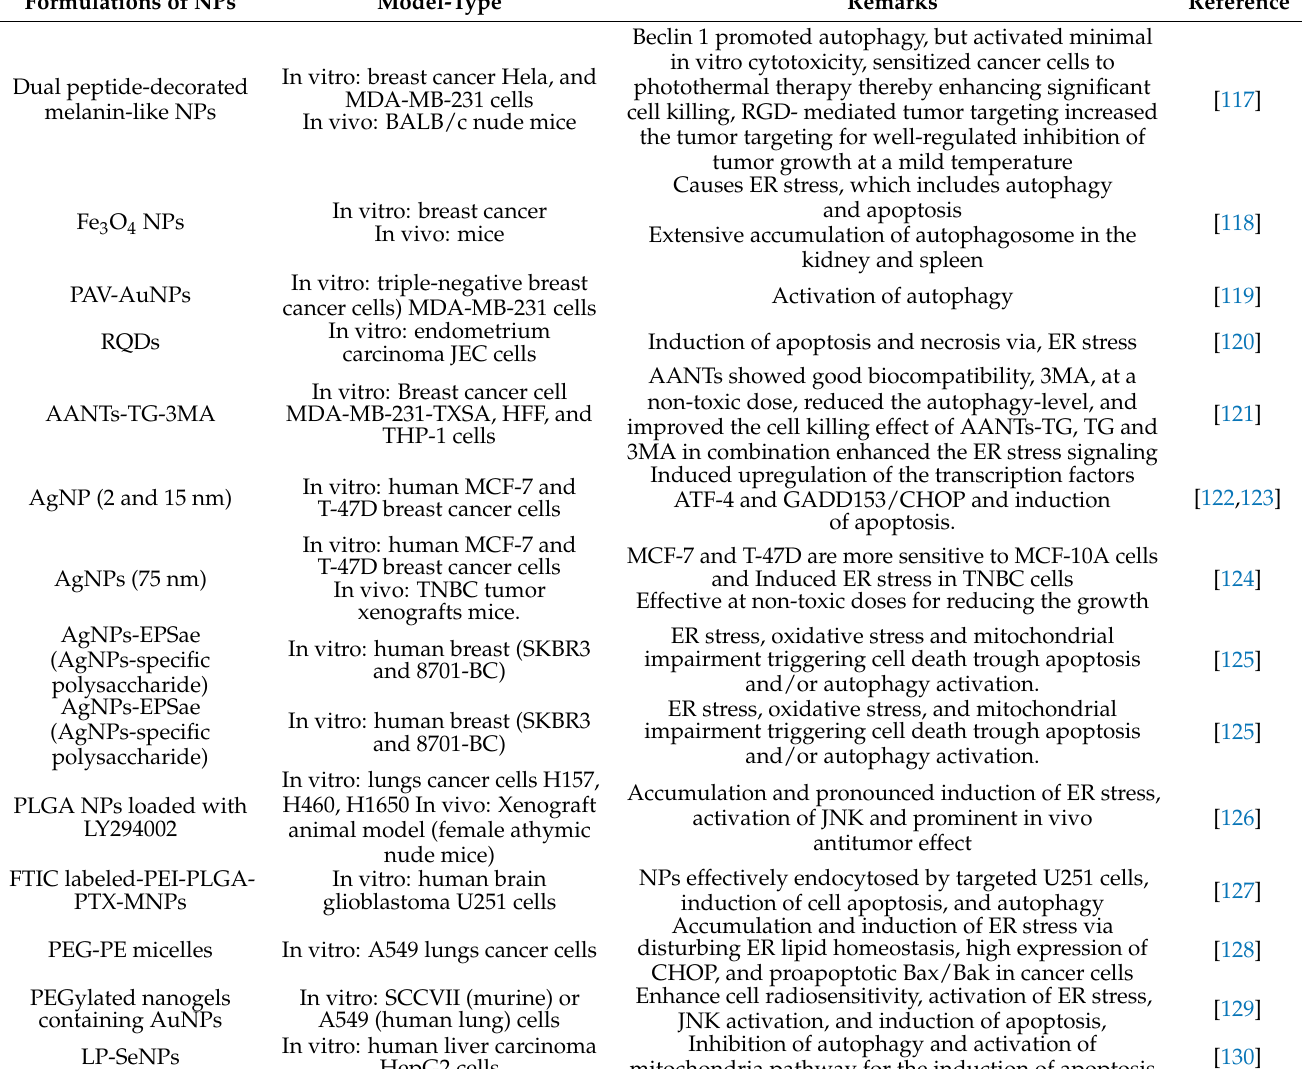
Table 2. Activation and modulation of ER stress, unfolded protein response, and autophagy in treating breast and other cancer